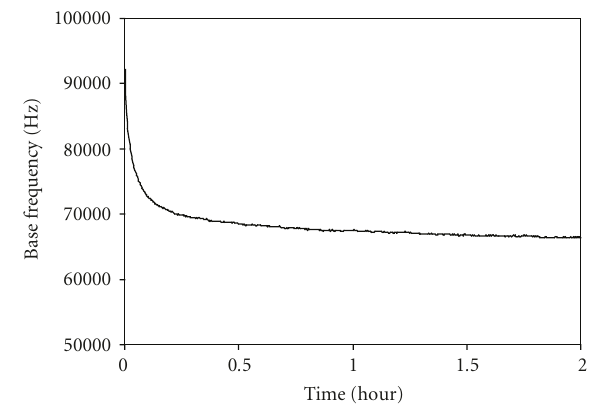
Figure 8: Drift over 2 hour period showing baseline stability attainable after 15 minutes initial warm-up